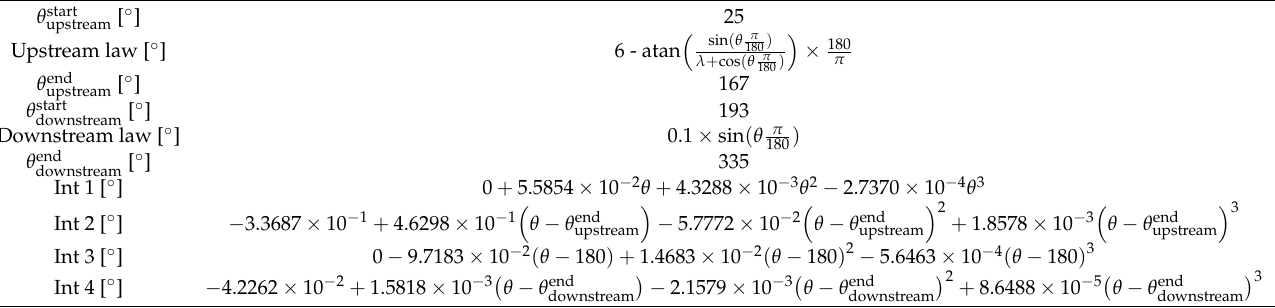
Table A1. Details of pitching law PL1 ( θ is always in degrees ( ◦ ) in the expressions).